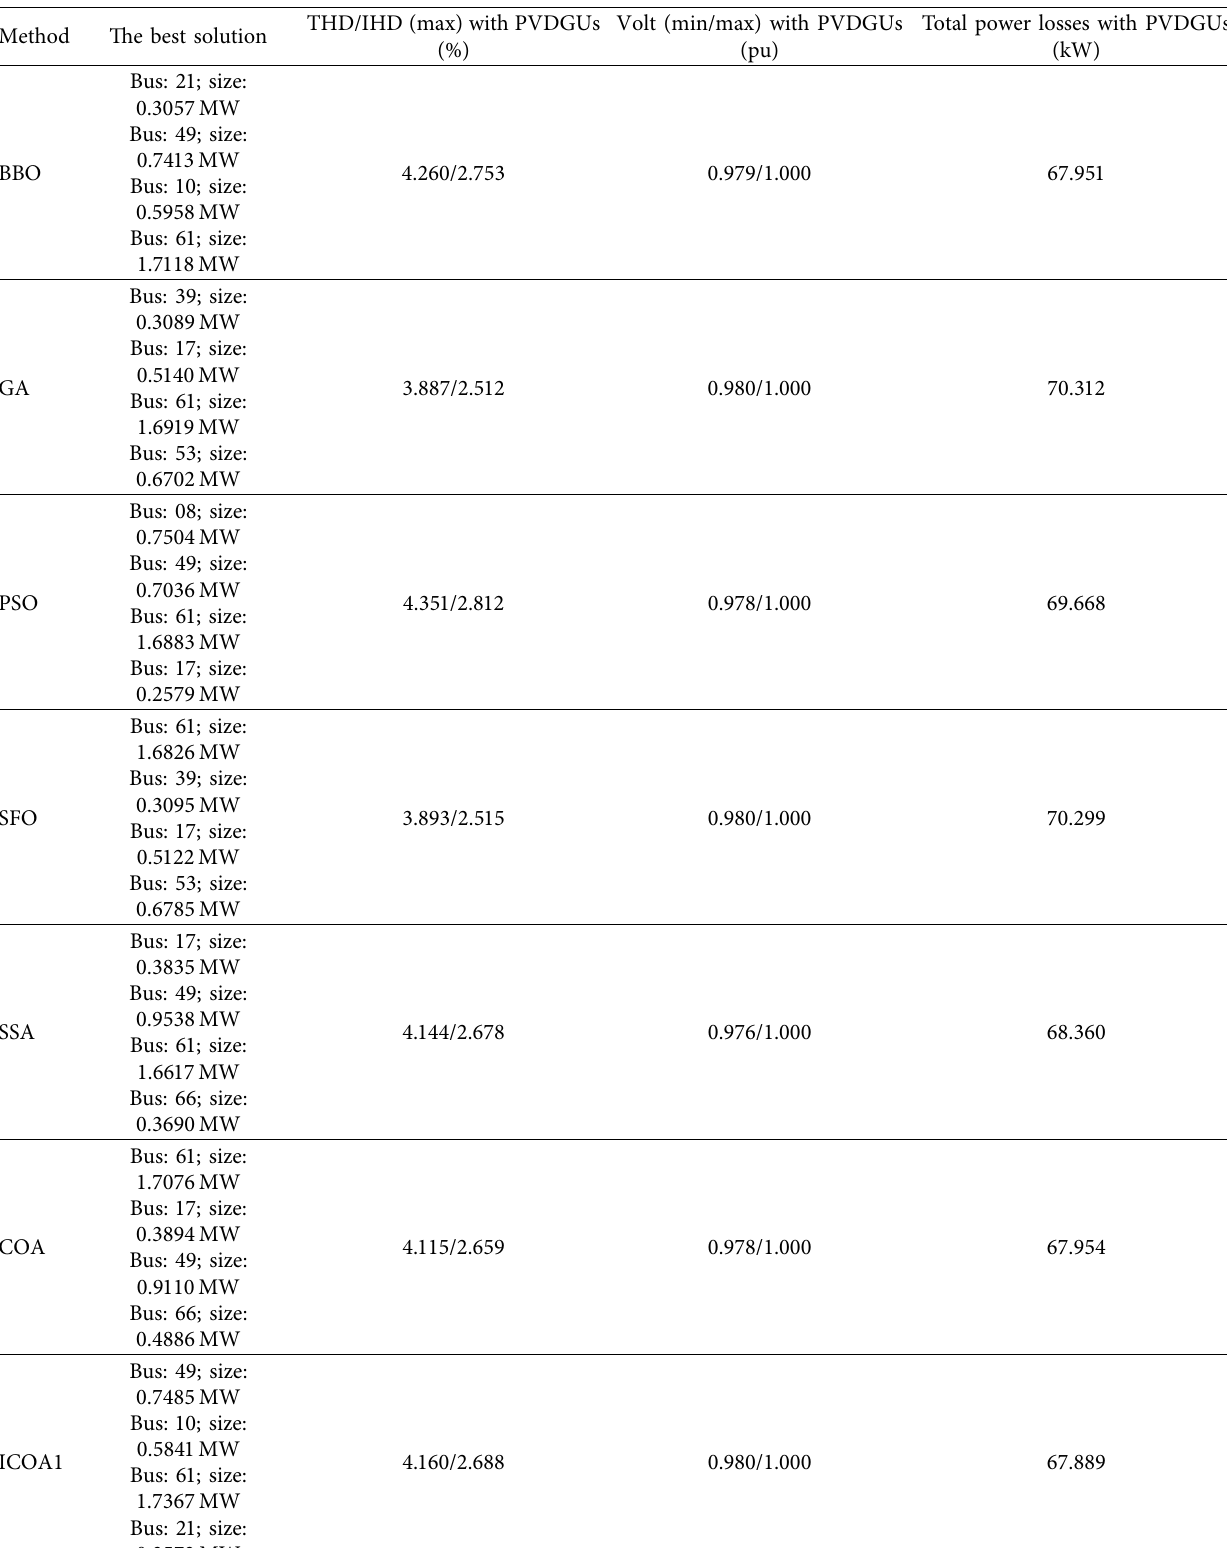
Table 16: The best solutions and the total capacity of PVDGUs found by nine implemented methods for the IEEE 69-bus distribution network in Case